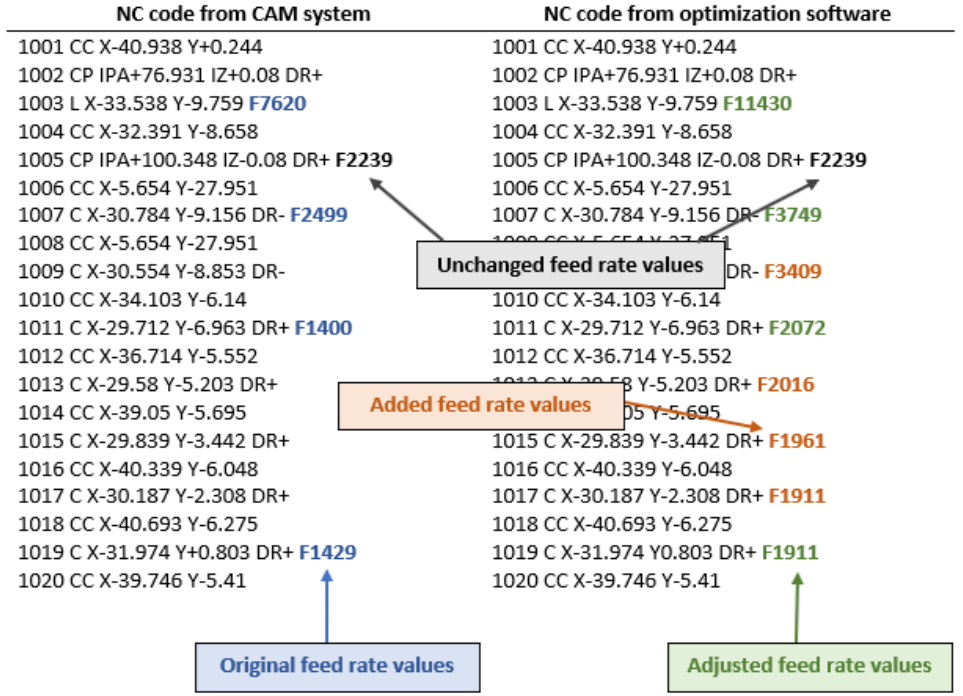
Figure 13. Comparison of NC codes from CAM system and optimization software.